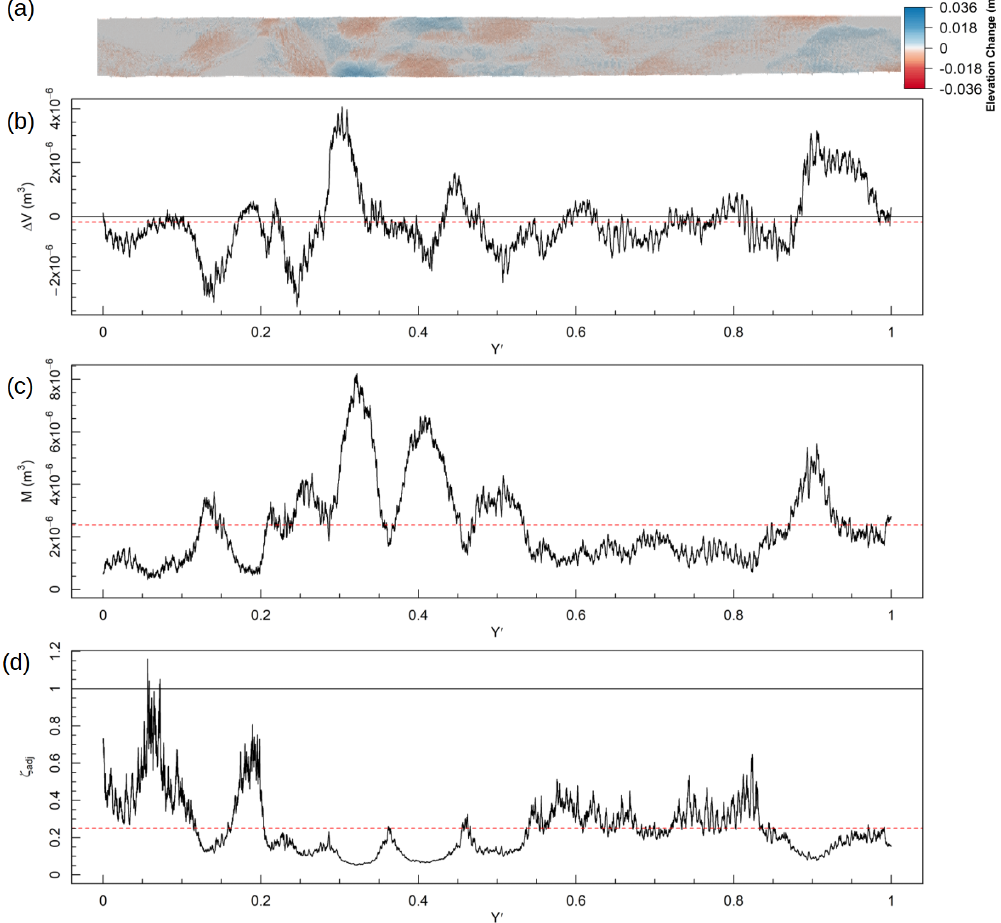
Figure 8. Example calculation of ζ for T = 15–20min in the fixed-bank experiment. Flow is from the right and Y (cid:48) represents the normalised distance upstream from the outlet. Panel (a) shows the whole DoD. Panel (b) shows (cid:49)V at each cross section, the black line shows (cid:49)V = 0, and the red dashed line shows mean (cid:49)V . Panel (c) shows M at each cross section, and the red dashed line shows mean M . Panel (d) shows the adjusted throughput ratio ( ζ adj ) calculated with Eq. (6c), the black line shows ζ = 1, and the red dashed line shows mean ζ .